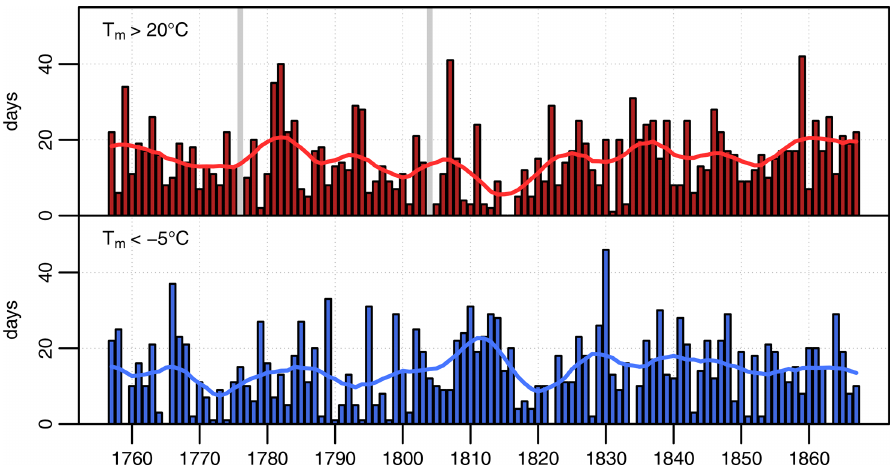
Figure 13. Number of days with mean temperature above 20 ◦ C in May–September (red) and below − 5 ◦ C in November–March (blue) in the Swiss Plateau series. The indices are not calculated in years when more than 10% of days are missing (indicated by grey bars). The smoothed lines are produced using a Gaussian filter with σ = 3 years.